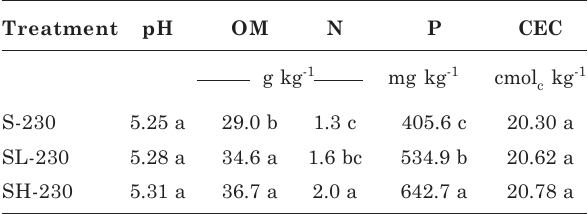
Table 2. Properties of soil and sewage sludge-treated soils 230 days after sewage sludge application Treatment pH